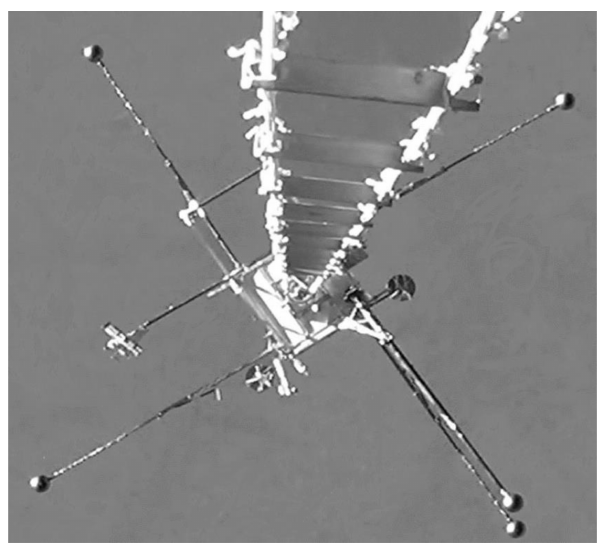
Figure 5. A snapshot of the payload viewed from the load line hang- ing from the